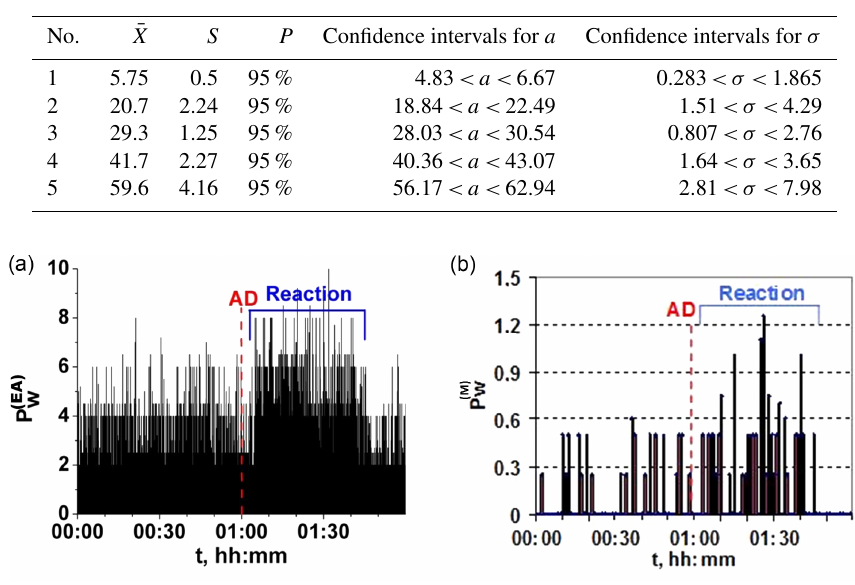
Figure 8. Time distribution of the whistler density before (00:00–01:00) and after (01:00–02:00) the acoustic disturbance (time is measured relative to the beginning of epoch). AD is the moment of acoustic disturbance. Distribution ( P ( EA ) epoch analysis method for data from 32 experiments, carried out on different days. Distribution ( P ( M ) filtration method for the same